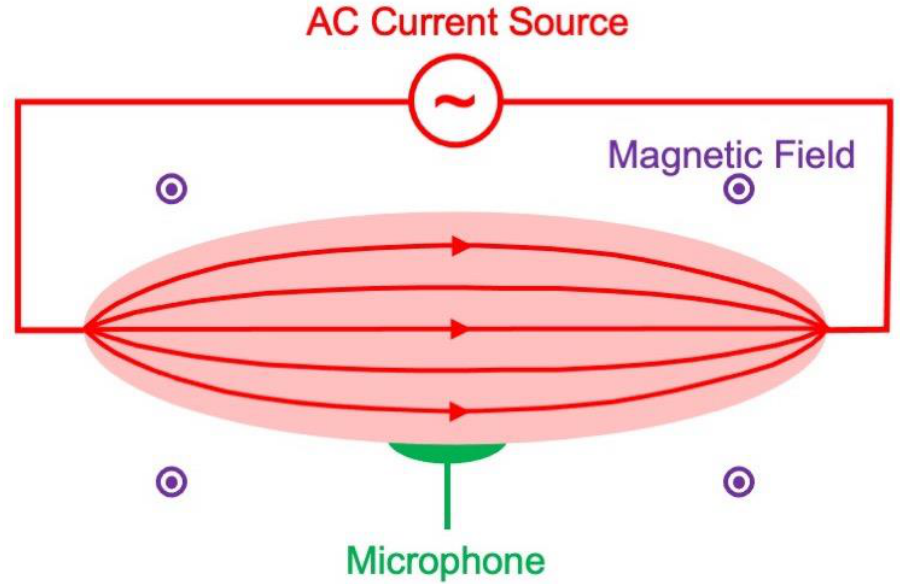
Figure 1. Magneto-acoustic imaging of current. The hamster is shown schematically in pink, the current in red, the microphone in green, and the magnetic field (directed out of the paper) in purple.